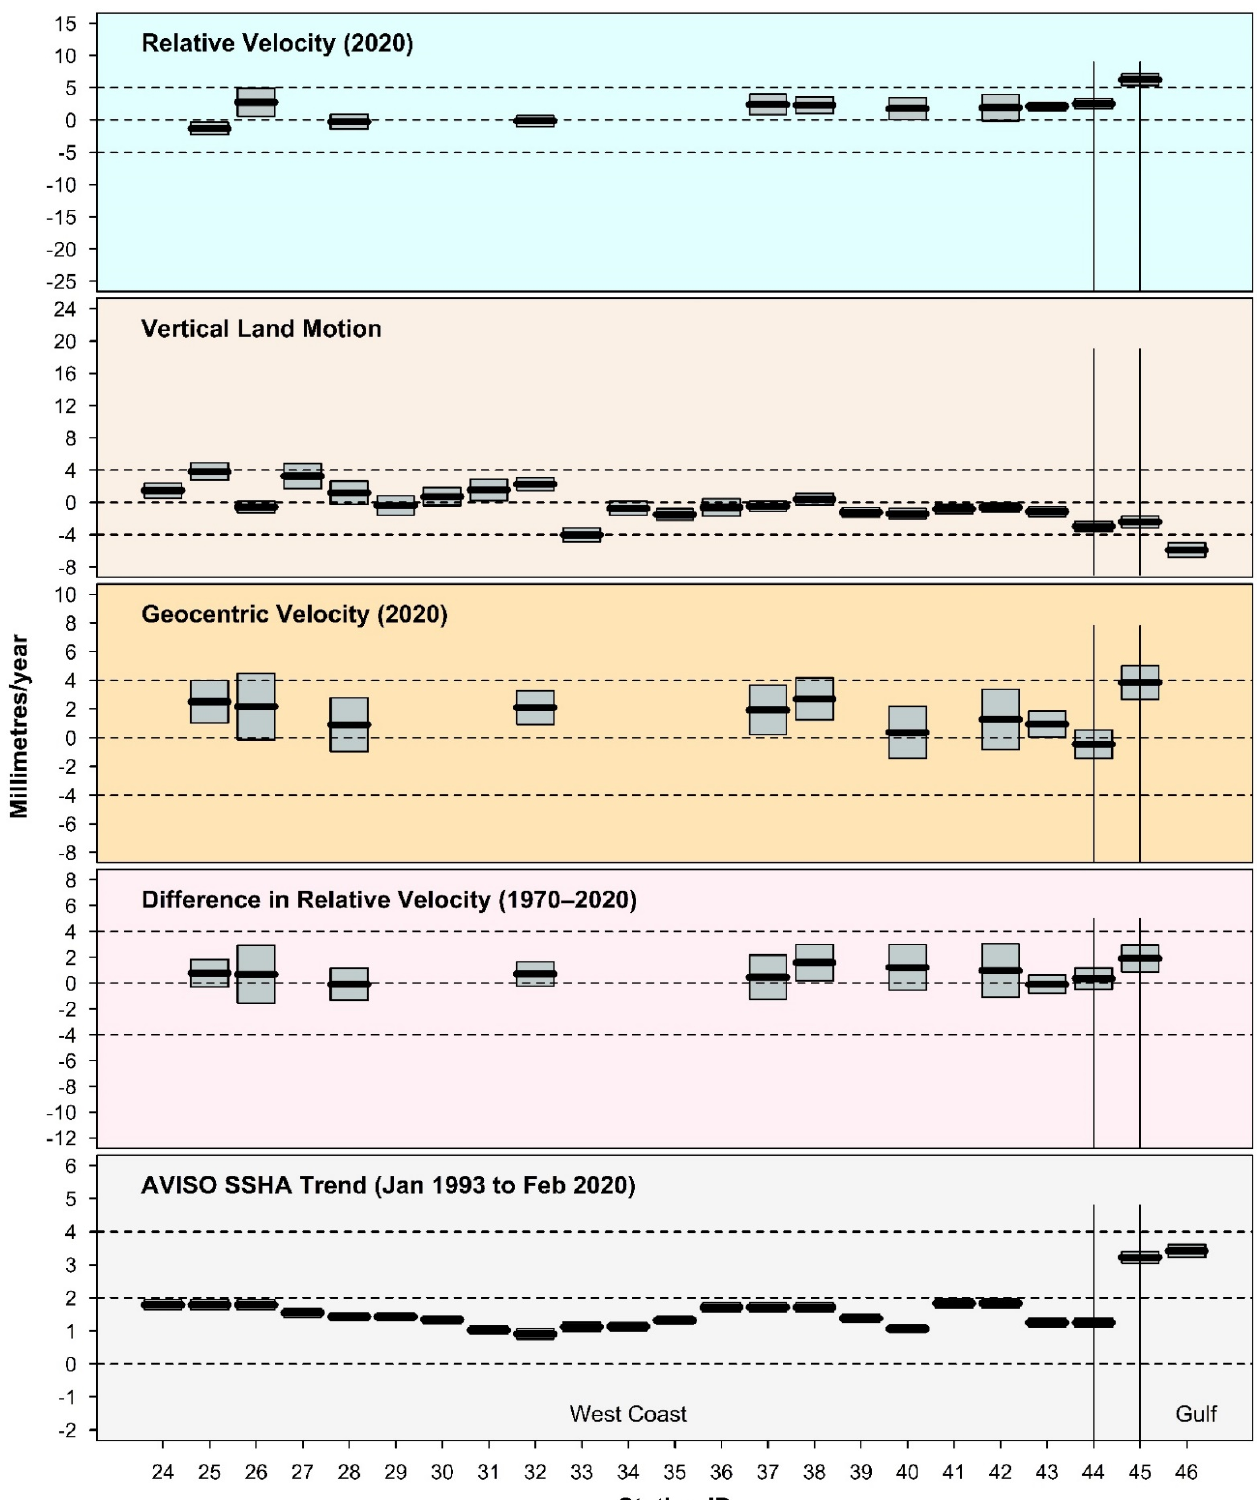
Figure 3. Summary of results for Station ID’s 24–46. Refer to Figure 1 and Table 1 for station ID details. Shaded boxes represent 95% CL for each set of results. Vertical lines demarcate respective sectors of coast which are denoted in the bottom panel. For details on the methodology underpinning the respective charts, refer Section 2.